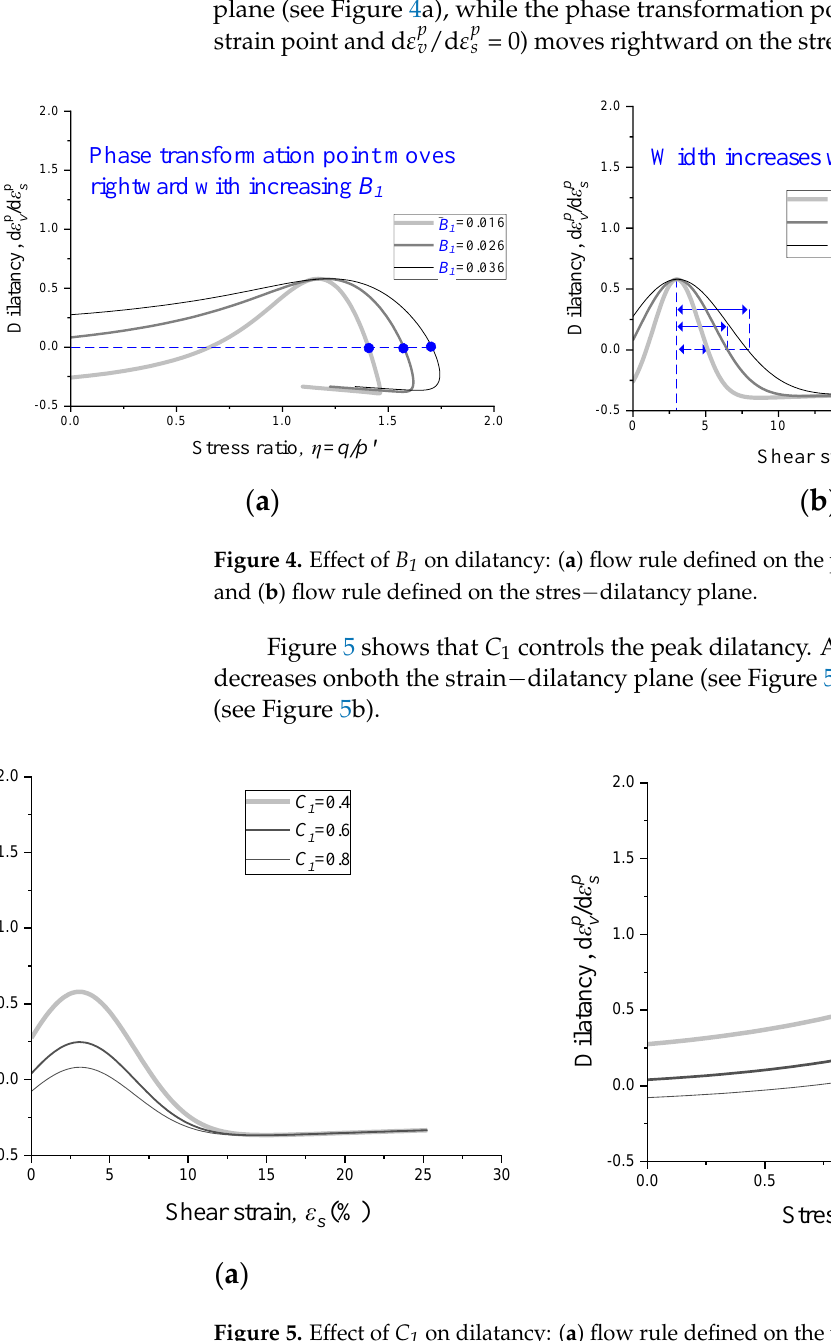
( b ) Figure 6. Effect of C 2 on dilatancy: ( a ) flow rule defined on the plane of dilatancy versus shear strain, and ( b ) flow rule defined on the stress − dilatancy plane. Figure 7 shows that